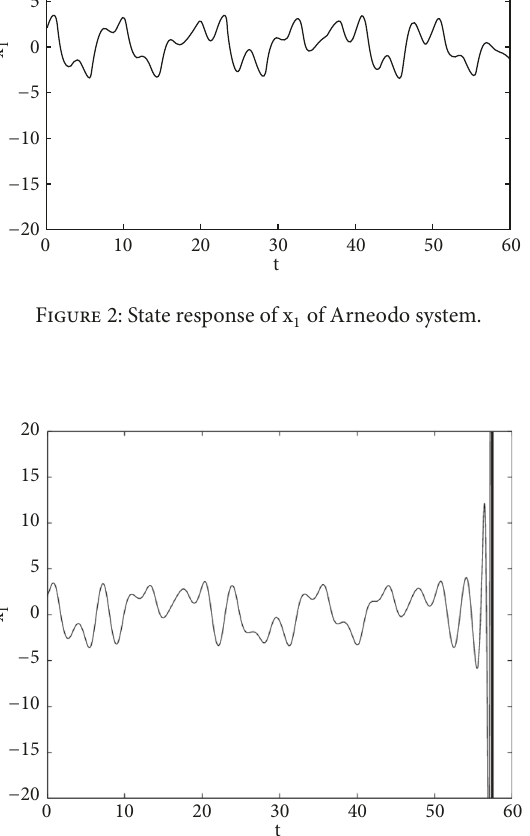
Figure 3: State response of x 1 of uncertain Arneodo system.